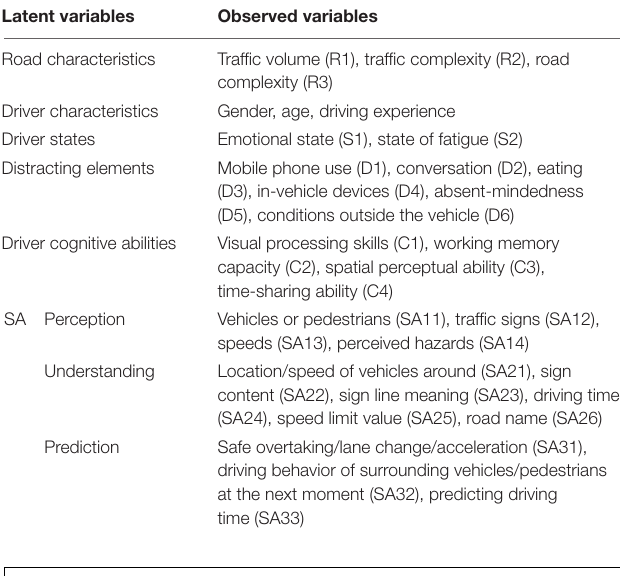
TABLE 1 | Hypothesis of latent variables.